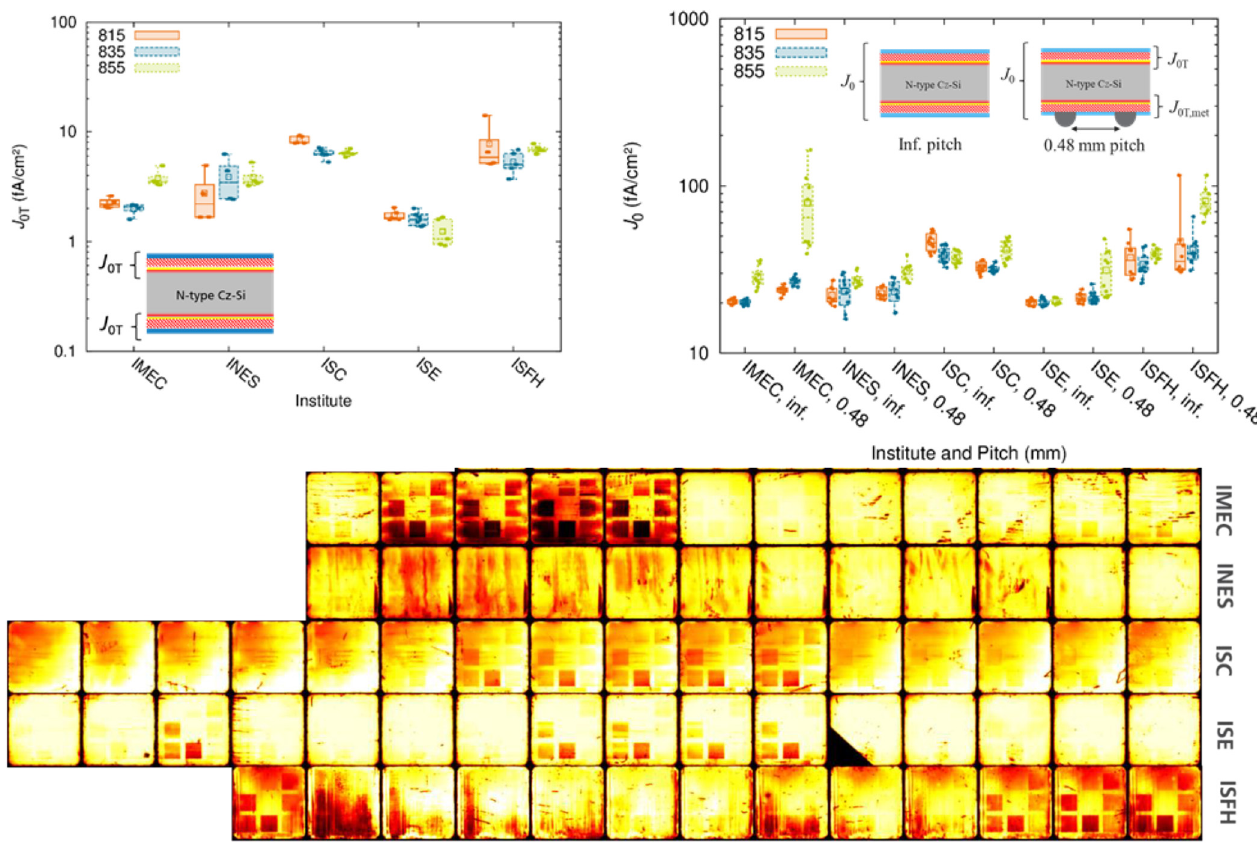
Fig. 2. Upper left graph: Dark saturation density J 0T from one single TOPCon layer extracted from fi eld F5. Upper right graph: Total dark recombination current-density J 0 either consisting of a bulk and two unmetallized TOPCon layers “ inf. ” (average F1 & F5) or a bulk and two TOPCon layers of which one side is being metallized (0.48mm pitch, average F3 & F8). Lower part: PL images of all specimens from all institutes showing partly no increased recombination or signi fi cant inhomogeneities of which both preventing a local J 0T,met